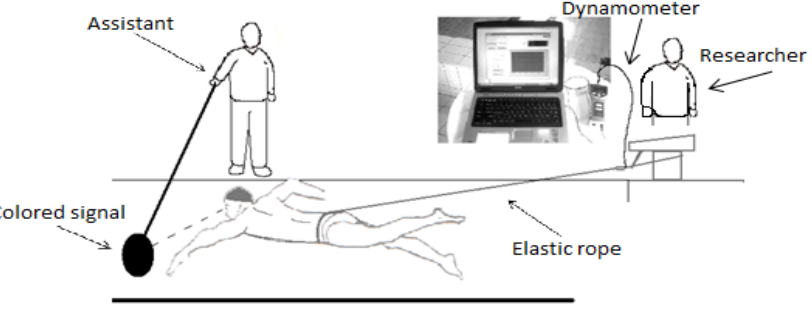
Figure 1. Schematic representation of the tethered-swimming apparatus. By means of